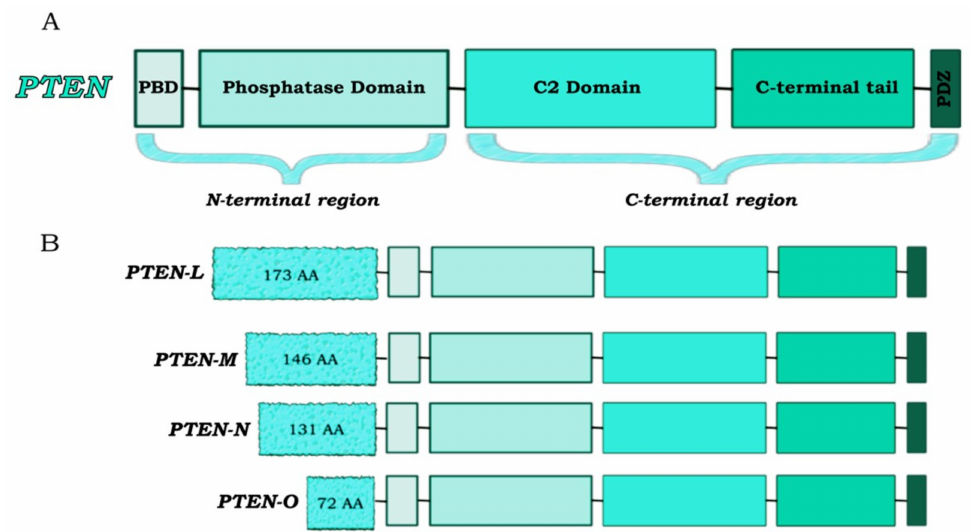
Figure 1. PTEN protein structure. ( A ) The canonical PTEN isoform consists of 403 amino acids structured in five functional domains: a phosphatidylInositol-4,5-bisphosphate (PIP2)-binding domain (PBD), a phosphatase domain (catalytic core), a C2 lipid membrane-binding domain, a C-terminal tail domain (which contains phosphorylation sites implicated in the regulation of PTEN activity/stability and localization) and a PDZ protein–protein interactions domain. ( B ) PTEN has four translational variants (PTEN-L, -M, -N and -O) which contain an additional N-terminus and differ in functions and sub-cellular localization. Translation begins from a translation site upstream the canonical initiation sequence and resulting in N-terminal extensions for each of the